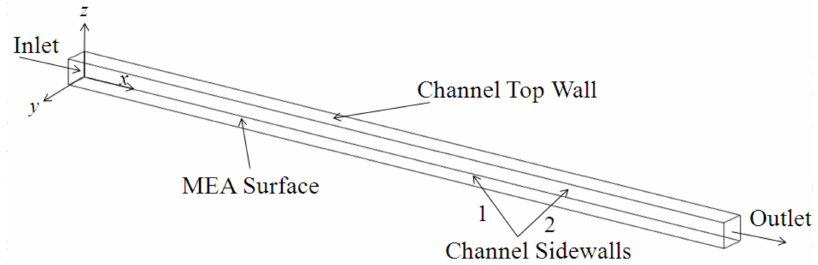
Figure 2. Schematic of the computational domain and associated coordinate